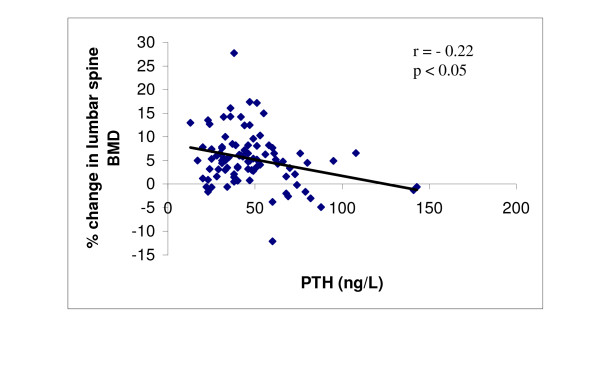
The relationship between percentage change in BMD at the Lumbar spine and PTH concentrations.